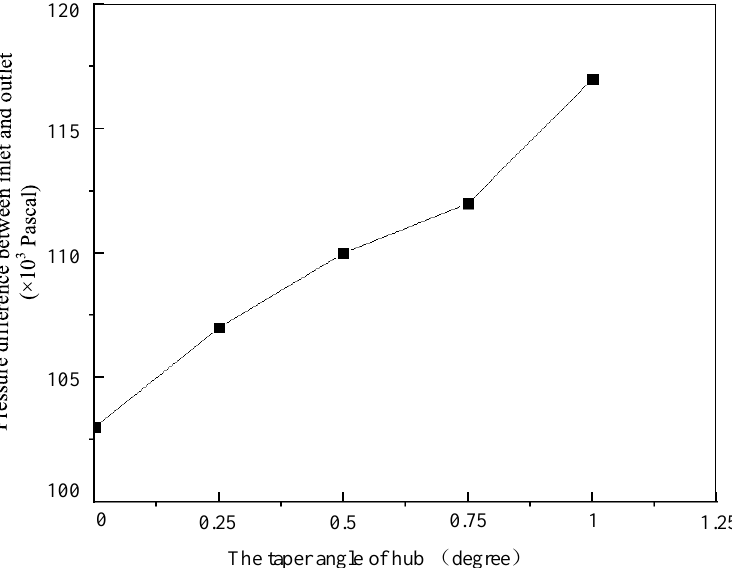
Figure 7. Relationship between the taper angle of the hub and the pressure difference between the inlet and outlet.